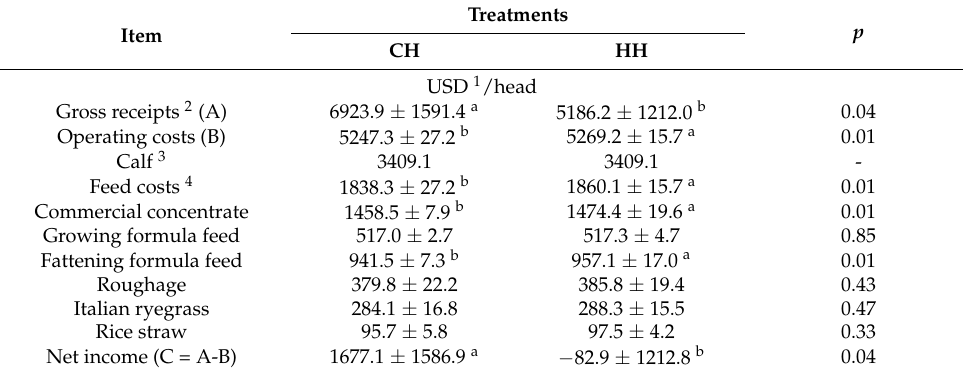
Table 4. Comparison of economy efficacy on castrated and hemi-castrated Hanwoo.